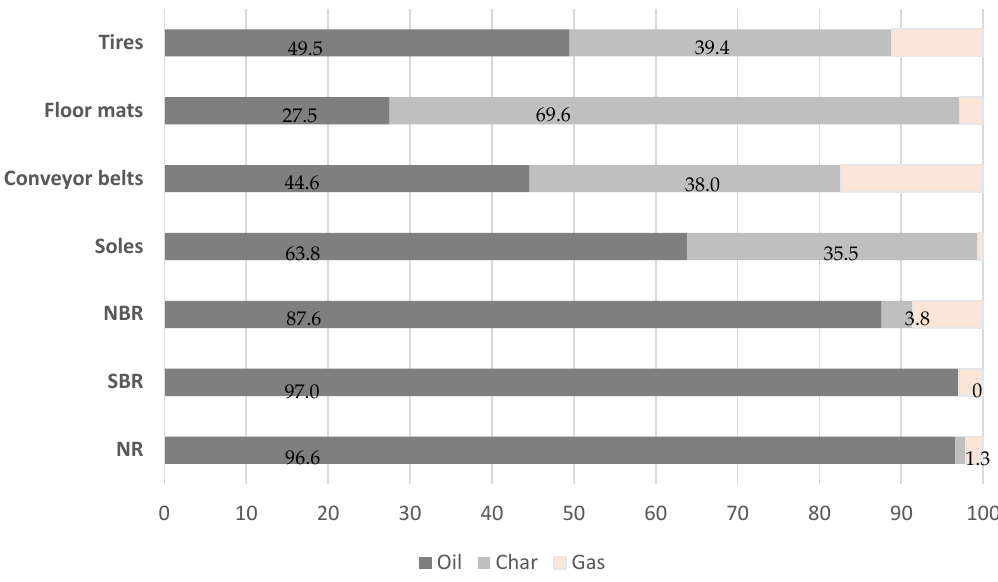
Figure 5. Product yields (wt.%) from the pyrolysis performed at 600 °C on a laboratory scale. It was observed that the pyrolysis of tires and conveyor belts provided 49.5 wt.% and 44.6 wt.%